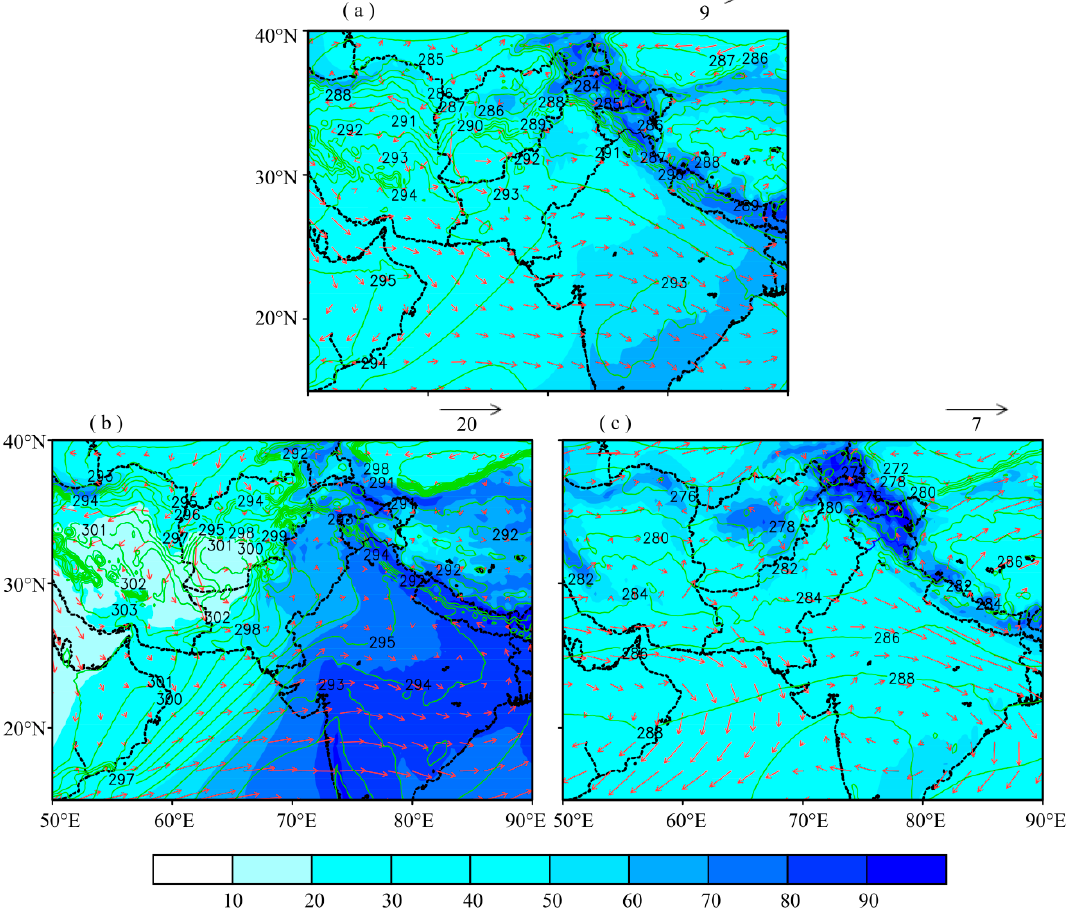
Figure 2. Synoptic meteorological conditions derived from the ECMWF, ERA-Interim reanalysis data sets at 850 hPa pressure level during 2003–2017, over and around the study domain; ( a ) Annual, ( b ) Summer, ( c ) Winter. The shaded color contour represents RH (%), and the green line contour represents air temperature (K), winds are represented by arrows pointing towards the wind direction and the length of arrows represent the wind speed (in ms − 1 ).